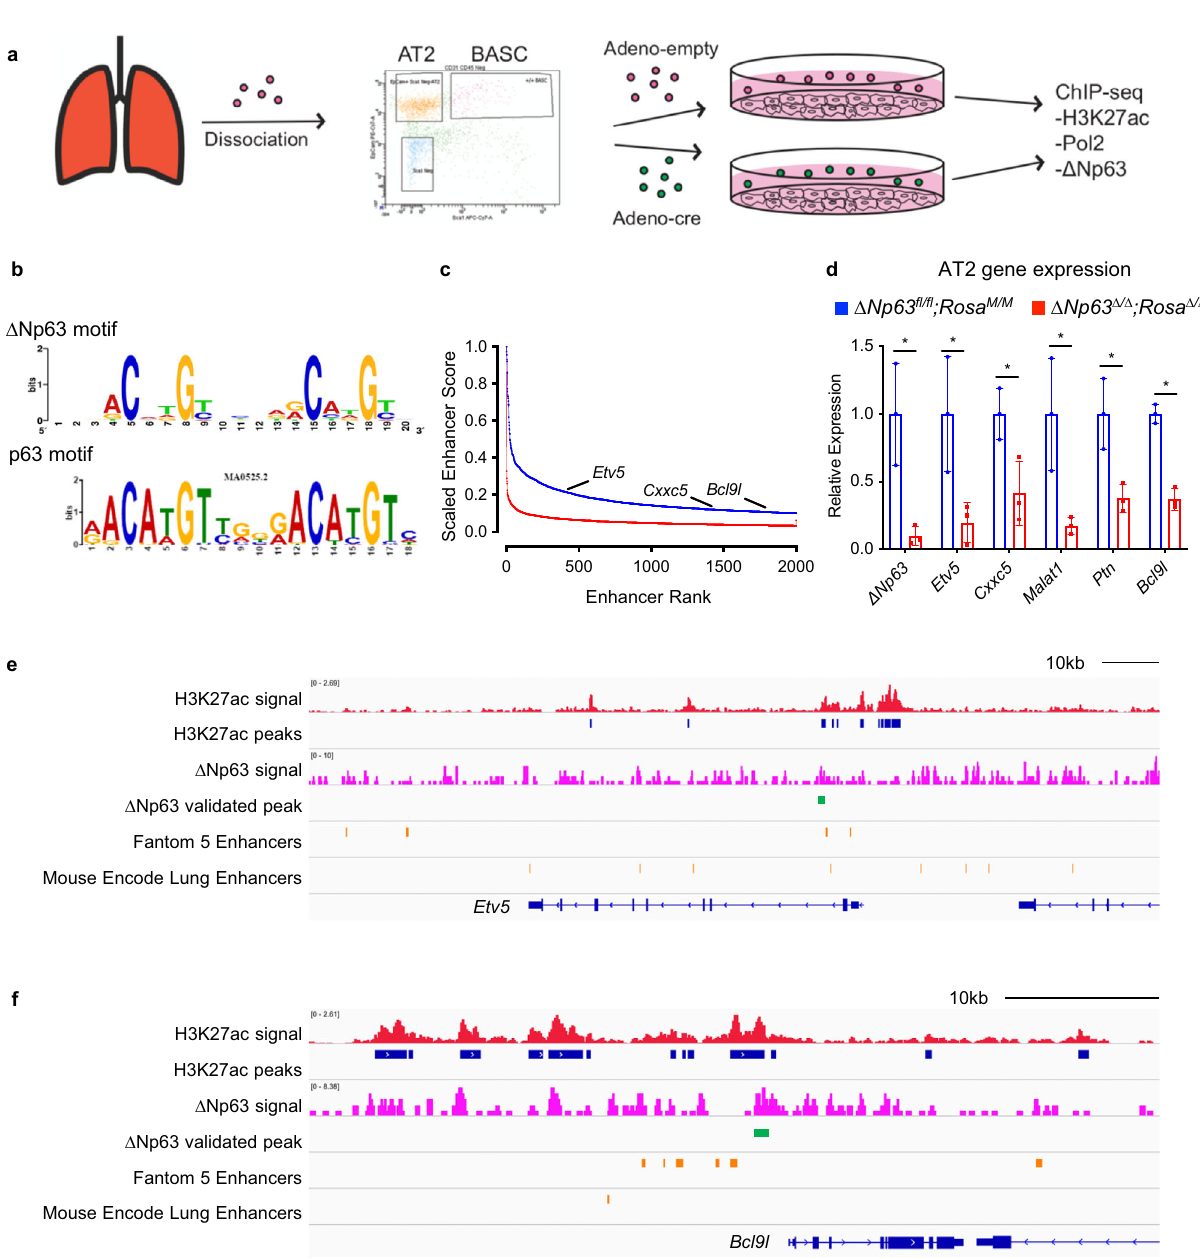
Fig. 6 Δ Np63 regulates self-renewal by controlling the enhancer landscape of cell identity genes in distal lung stem cells. a Schematic of isolation of Δ Np63 fl / fl ; Rosa M/M and Δ Np63 Δ / Δ ; Rosa Δ / Δ AT2 cells for RNA-seq and ChIP-seq. b Δ Np63 motif derived from AT2 cell Δ Np63 ChIP-seq compared to published p63 motif. c Ranking of top 2000 enhancers based on H3K27ac ChIP-seq in Δ Np63 fl / fl ; Rosa M/M (blue) and Δ Np63 Δ / Δ ; Rosa Δ / Δ (red) AT2 cells. d qRT-PCR of the indicated genes in Δ Np63 fl / fl ; Rosa M/M and Δ Np63 Δ / Δ ; Rosa Δ / Δ AT2 cells. Data were mean ± SD, n = 3, * vs. Δ Np63 fl / fl , P < 0.05, two-tailed Student ’ s t -test. e , f ChIP-seq pro fi les of Δ Np63 fl / fl ; Rosa M/M AT2 cells for the indicated tracks in the Etv5 ( e ) and Bcl9l ( f ) loci. Source data are provided as a Source Data fi